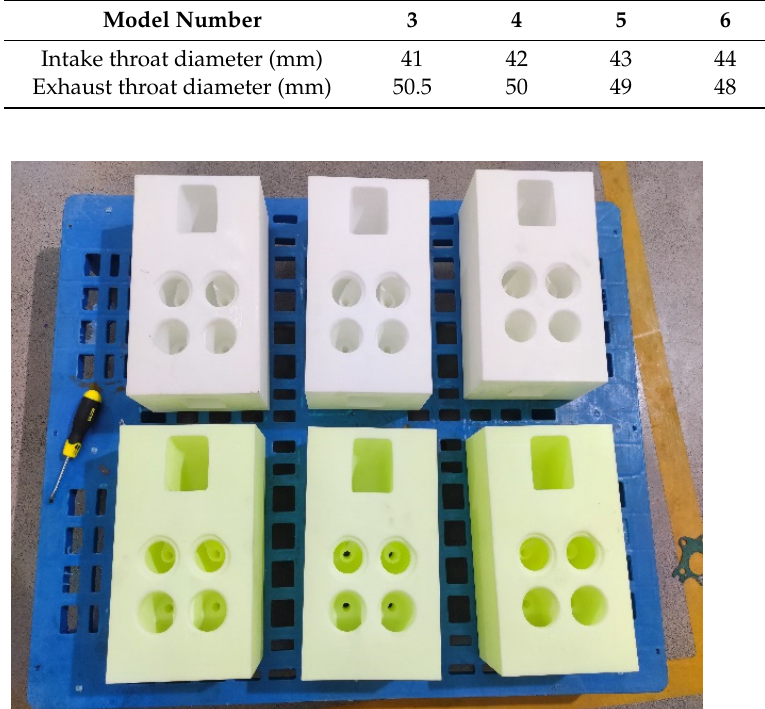
Figure 6. The physical diagram of the intake and exhaust core box with different throat diameters. Table 4. Accuracy requirements of test